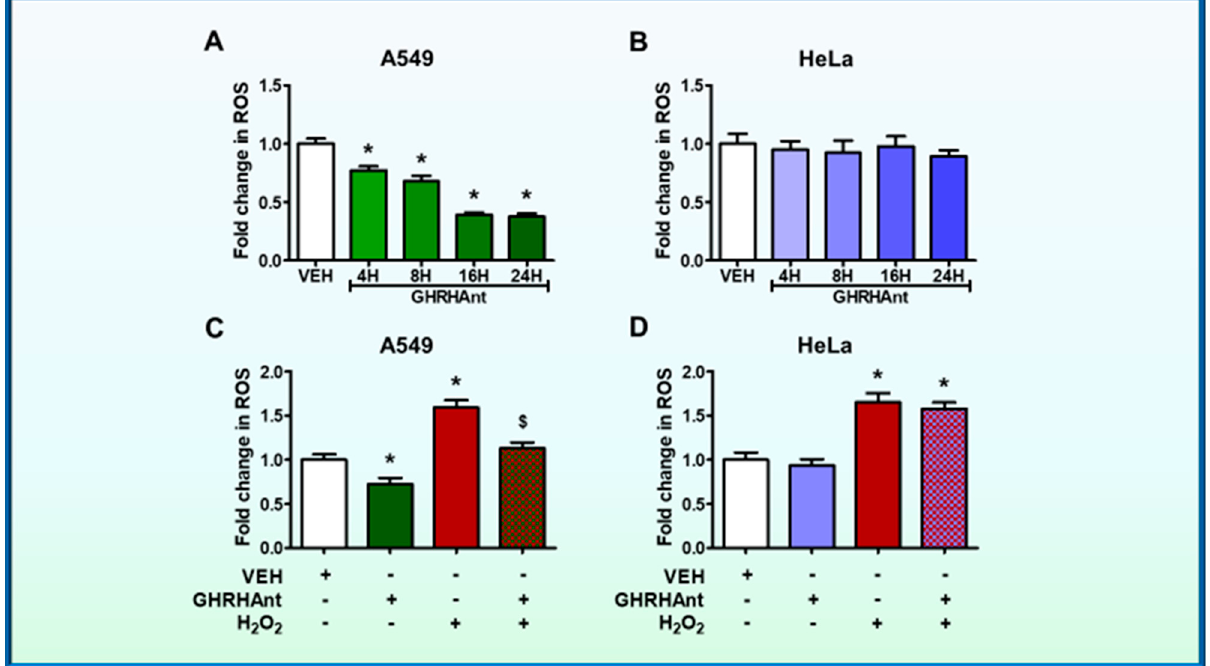
Figure 2. GHRHAnt protect against hydrogen peroxide (H 2 O 2 )-induced ROS generation. Microplate reader analysis of ROS in ( A ) A549 and ( B ) HeLa cells. The cells were treated with vehicle (VEH) (0.1% DMSO) or GHRHAnt (1 μ M) for 4, 8, 16, and 24 h. The fold change in the ROS generation of GHRHAnt-treated cells was compared to the vehicle-treated cells. n = 4 per group. Means ± SEM. ( C ) A549 and ( D ) HeLa cells were pretreated with VEH (0.1% DMSO) or GHRHAnt (1 μ M) for 8 h before VEH (PBS) or H 2 O 2 (0.1 mM) exposure (8 h). The fold change in the ROS generation of the cells treated with H 2 O 2 and/or GHRHAnt was compared to that of the cells treated with vehicle. n = 4 per group. Means ± SEM. * p < 0.05, vs. VEH; $ p < 0.05 vs. H 2 O 2